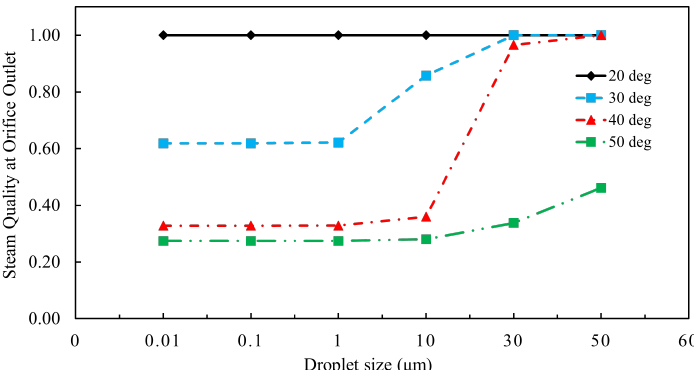
Figure 13. Steam quality at the orifice outlet for various droplet sizes and vane bending angles.